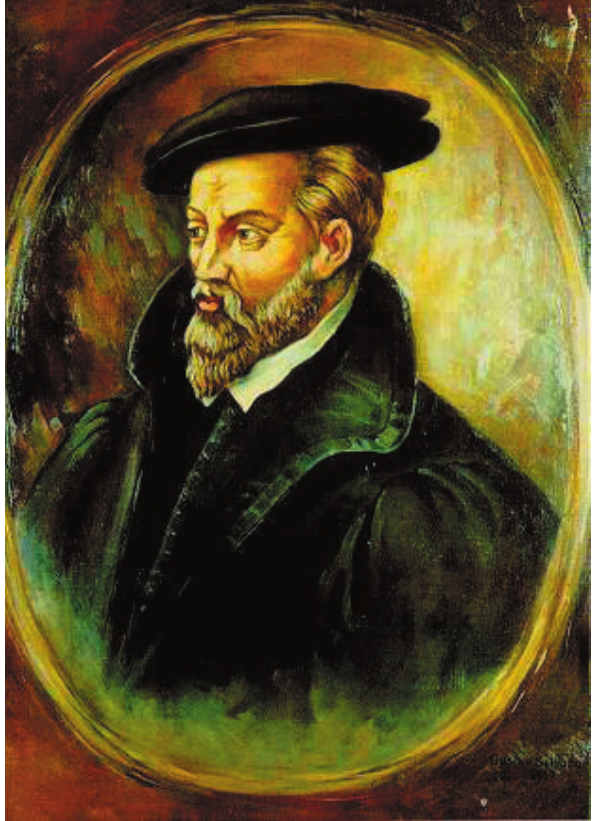
Fig. 4. Portrait of Georgius Agricola (unknown painter,